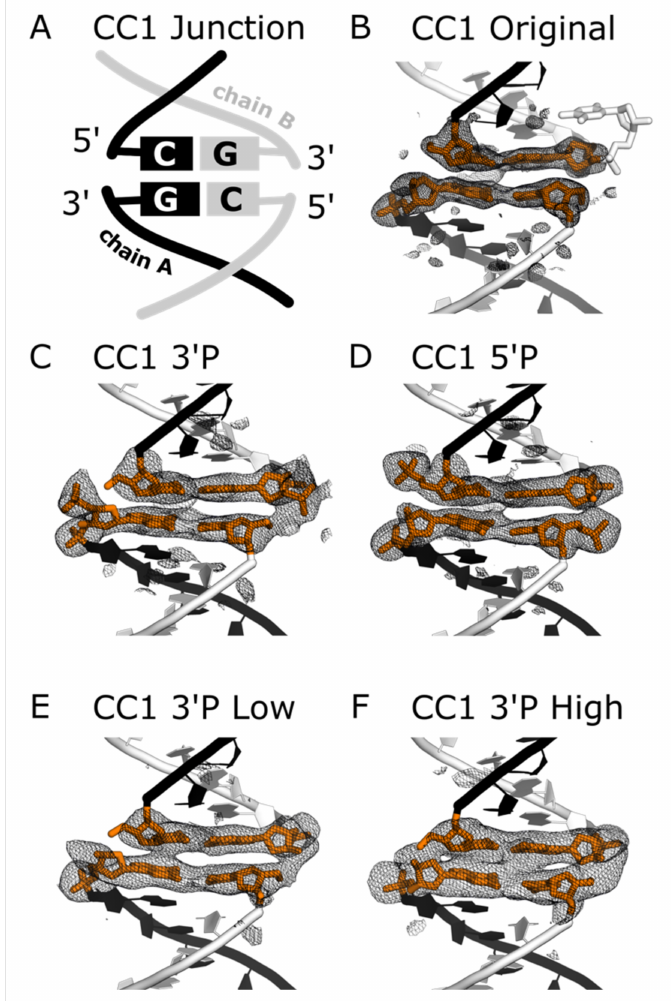
Figure 5. Omit maps for ( A ) the CC1 DNA–DNA junction. ( B ) Our updated model for the original structure resolves one of the dangling 5 (cid:48) terminal bases (white sticks). Prior to ligation, CC1 crystals grow with either ( C ) terminal 3 (cid:48) phosphates or ( D ) terminal 5 (cid:48) phosphates. Whereas ( E ) low dose EDC ligation results in minor changes to the electron density for CC1 with 3 (cid:48) phosphates, ( F ) high dose EDC ligation results in electron density consistent with ligated DNA. Neighboring protein is hidden for clarity. All meshes are omit maps (mF o -DF c ) contoured at 3.0 rmsd. All four bases flanking the junction (orange sticks) were omitted. To faithfully represent COOT contours in PyMOL, we turned off automatic map normalization and instead set the contour level to 3.0 rmsd. Table S4 has the corresponding e/Å 3